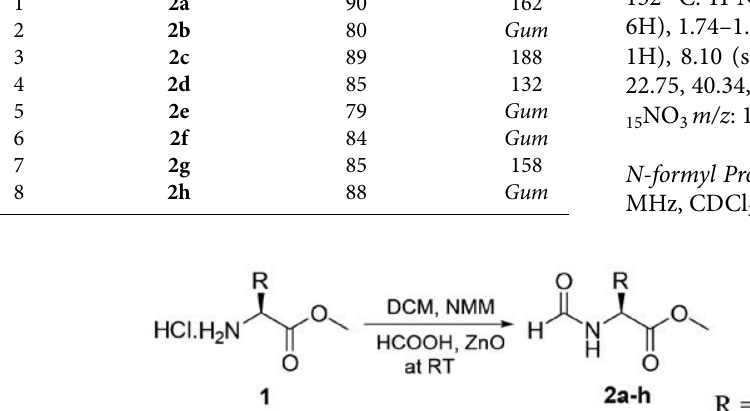
Table 1. List of formamide esters prepared using ZnO NPs Entry